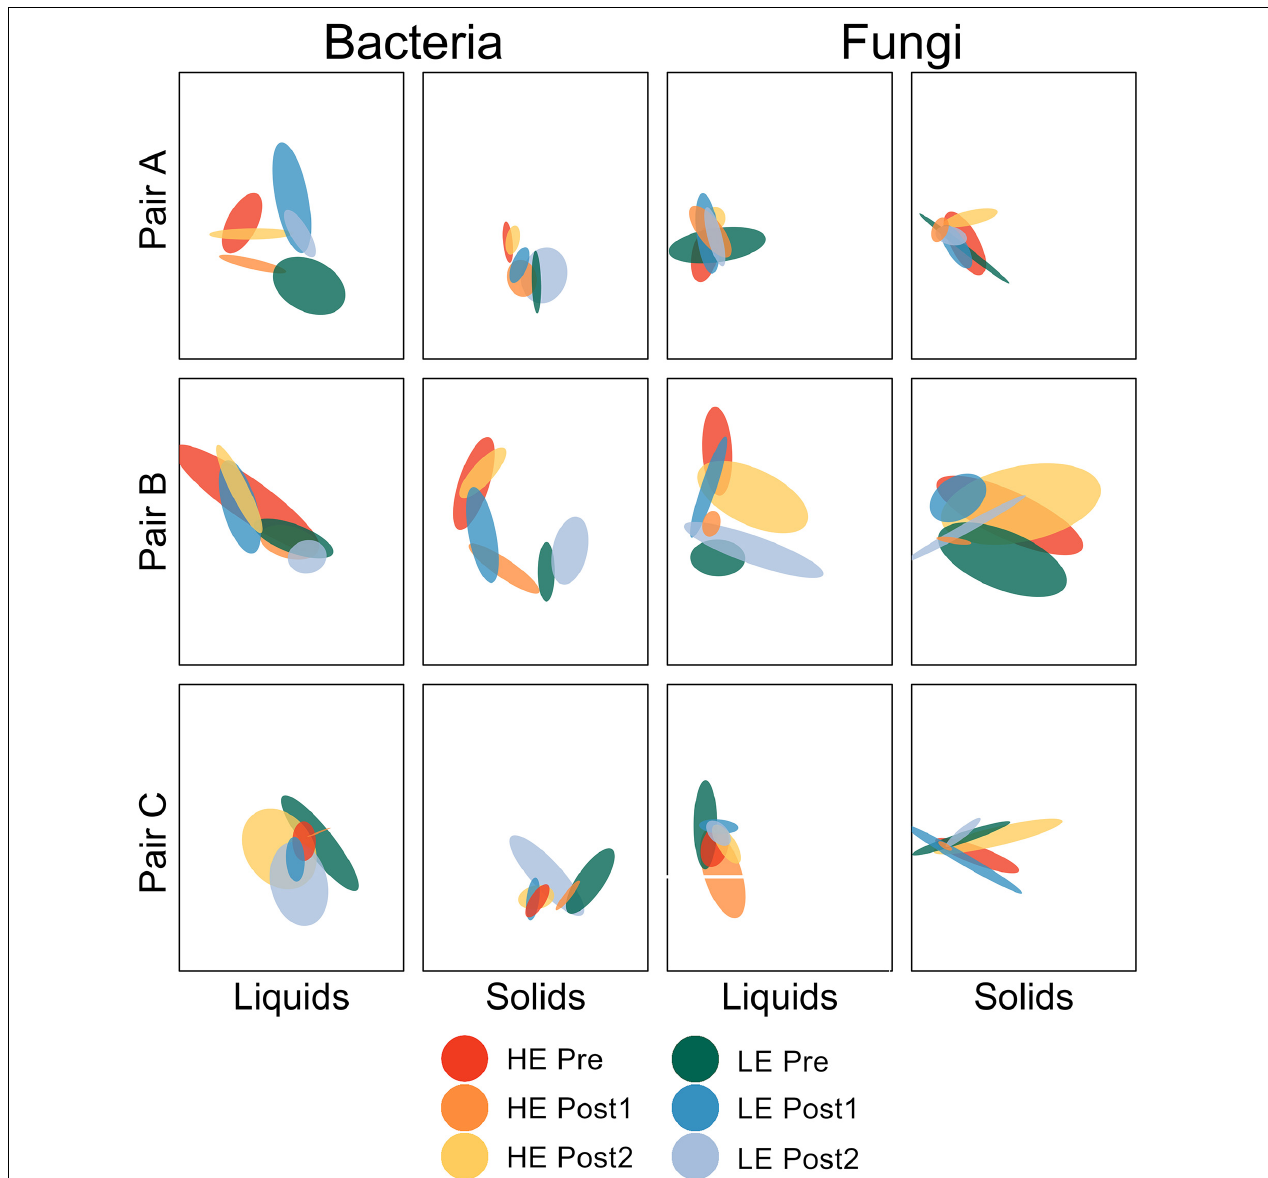
FIGURE 1 | Non-metric multidimensional scaling plot depicting Bray-Curtis dissimilarity of bacterial and fungal communities by pair of host animals. Standard error ellipses are color coded by initial MPE of host and time within